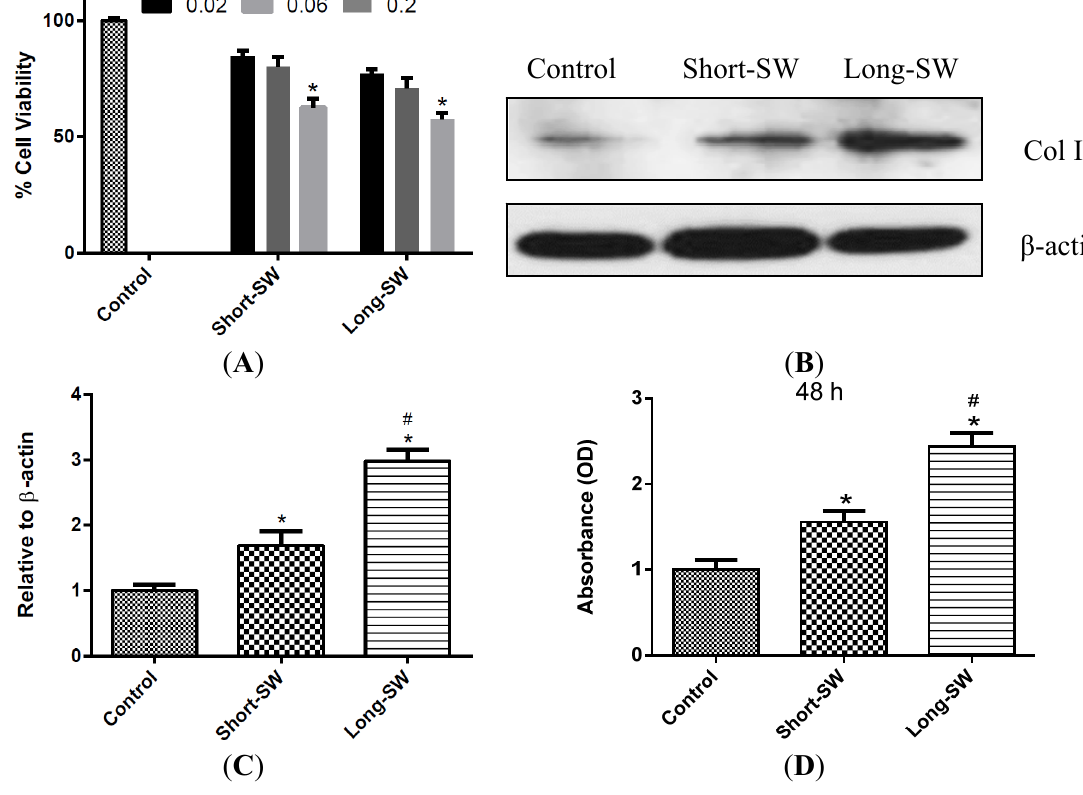
Figure 1. Effect of Single-Walled Carbon Nanotubes (SWCNTs) on cell viability and type I collagen expression. ( A ) Subconfluent cultures of normal human lung fibroblasts (NHLF) cells were exposed to SWCNTs of various lengths for 48 h within the concentration range of 0.02–0.2 µg/cm 2 and compared to untreated control by WST-1 colorimetric assay; ( B ) Western blots showing length-dependent effect of SWCNTs on collagen I production. Subconfluent cultures of NHLFs were treated with SWCNTs with various lengths for 48 h and analyzed for collagen I expression by Western blotting. Blots were reprobed with β -actin antibody to confirm equal loading of the samples. The immunoblot signals were quantified by Image J.; ( C ) Relative protein quantification via Image J.; ( D ) NHLFs were treated with SWCNTs for 48 h at 0.06 µg/cm 2 and analyzed for soluble collagen content by Sircol ® assay. Values are mean ± S.D. ( n = 3); * p < 0.05 as compared to untreated control; # p < 0.01 vs. Short-SW